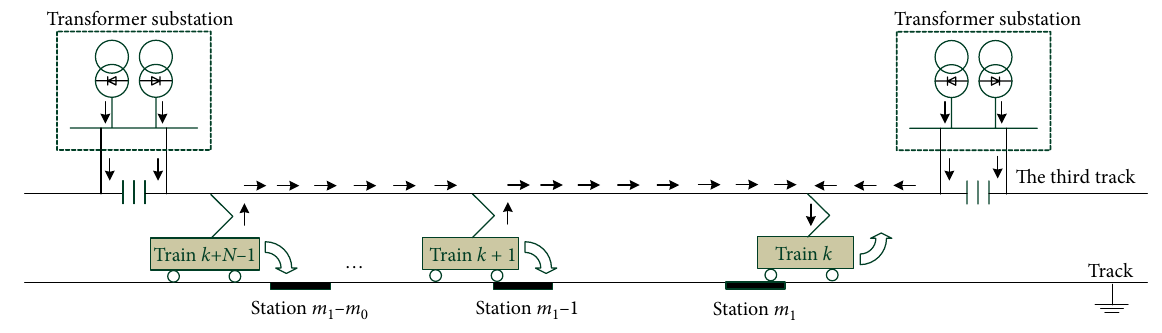
Figure 5: A schematic of regenerative braking energy utilization. Note: Figure 5 imitates the drawing style of [26].